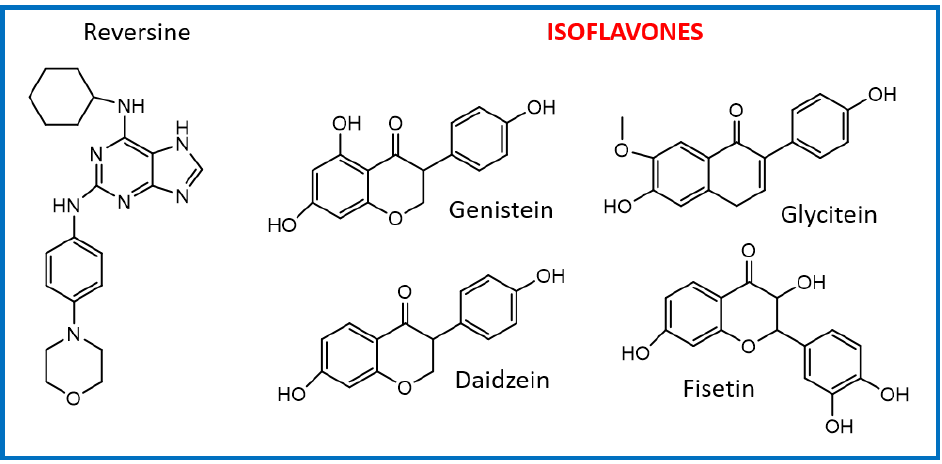
Figure 4. Comparison of the chemical structures of the isoflavones daidzein, fisetin, genistein, and glycitein and the Mps1 inhibitor reversine.